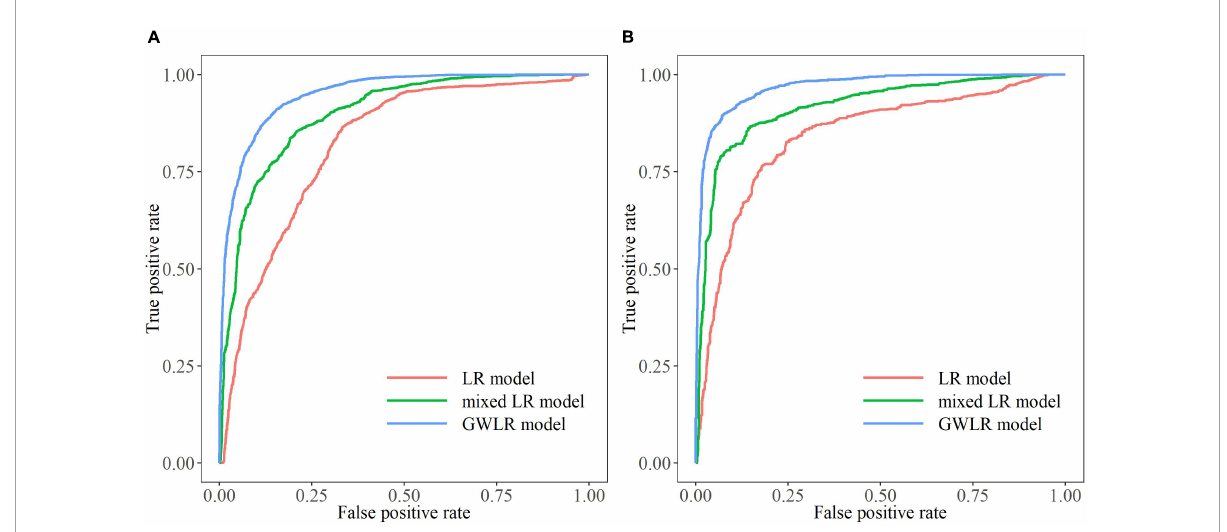
FIGURE5 The receiving operating characteristic (ROC) curves of different models. (A) ROC curves in spring fire prevention period. (B) ROC curves in autumn fire prevention period.